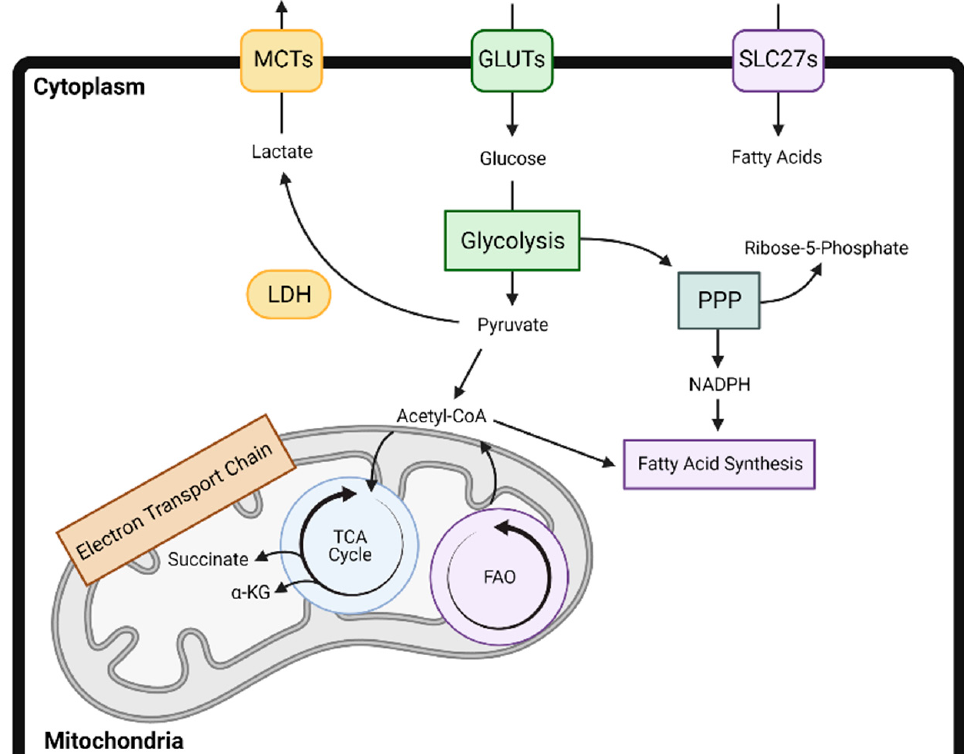
Figure 1. An overview of the major metabolic pathways including glycolysis, the tricarboxylic acid cycle, fatty acid synthesis, fatty acid oxidation, oxidative phosphorylation, and the pentose phosphate pathway and their interactions. α -KG—alpha-ketoglutarate; FAO—fatty acid oxidation; GLUT—glucose transporter; LDH—lactate dehydrogenase; MCT—monocarboxylate transporter; PPP—pentose phosphate pathway; SLC27—Solute carrier family 27; TCA—tricarboxylic acid.